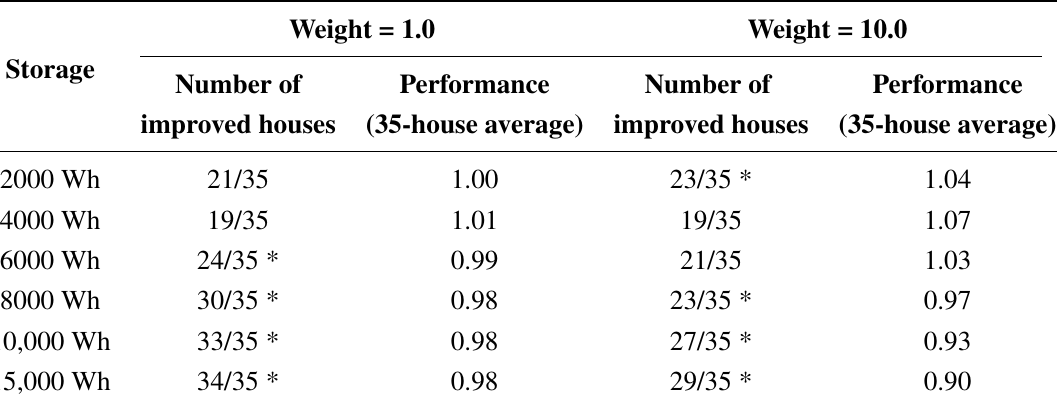
Table 2. Comparison of annual